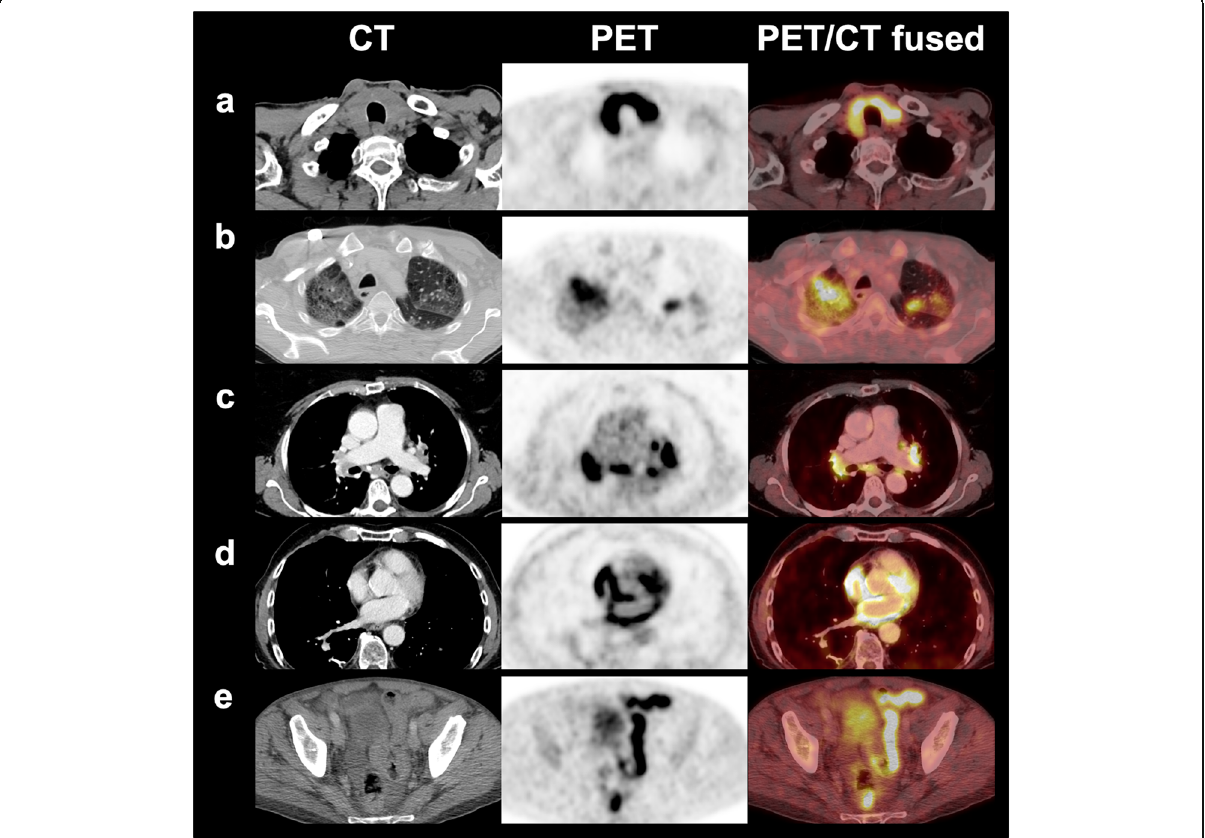
Fig. 3 Examples of immune-related adverse events on positron emission tomography/computed tomography with intensely increased 18 F-FDG uptake. a Thyroiditis. b Pneumonitis. c Sarcoid-like reaction. d Pericarditis. e